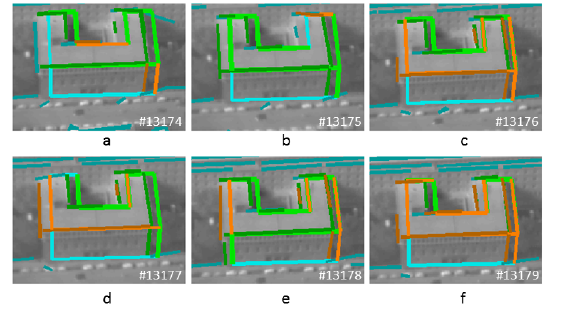
Figure 4: Outlier detection for one building across a sub- sequence of 6 images (13174-13179). Color coding: same as Fig.